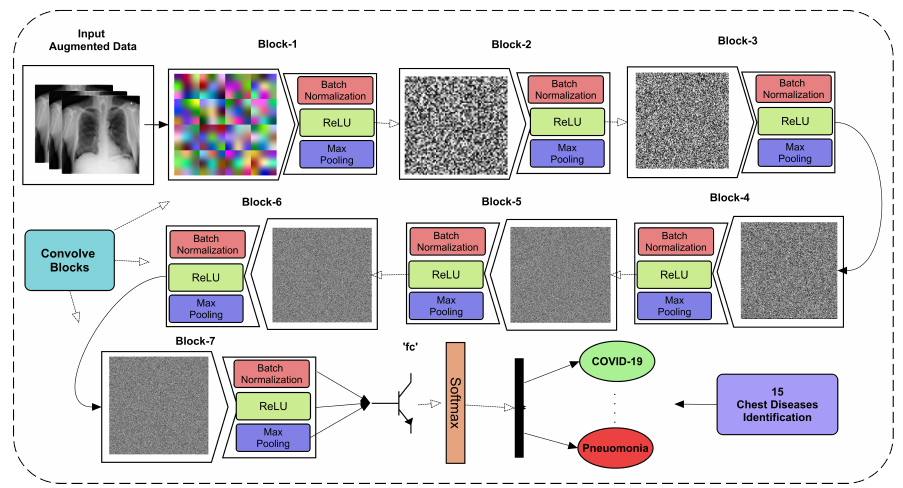
Figure 3. Proposed CNN design with convolve layer weight activation.